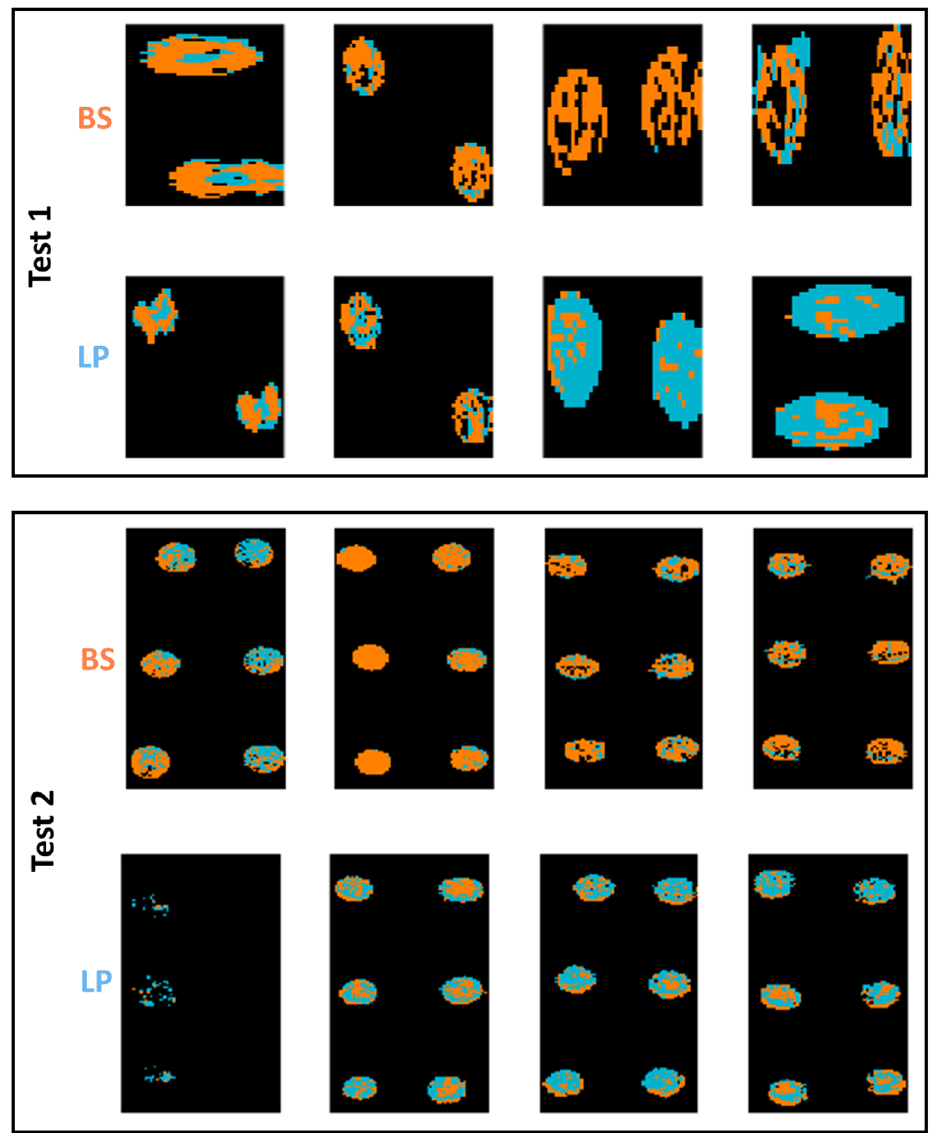
Figure 11. Classification maps samples in the test set (reps 6, 9, 12, and 16) obtained from the best pixel-level PCA-LSTM VNIR/SWIR model for GP BS/LP classification (pixels classified as BS/LP are shown in orange or blue respectively). Each replicate has two drops. BS: Bacillus subtilis ; LP: Lactobacillus plantarum